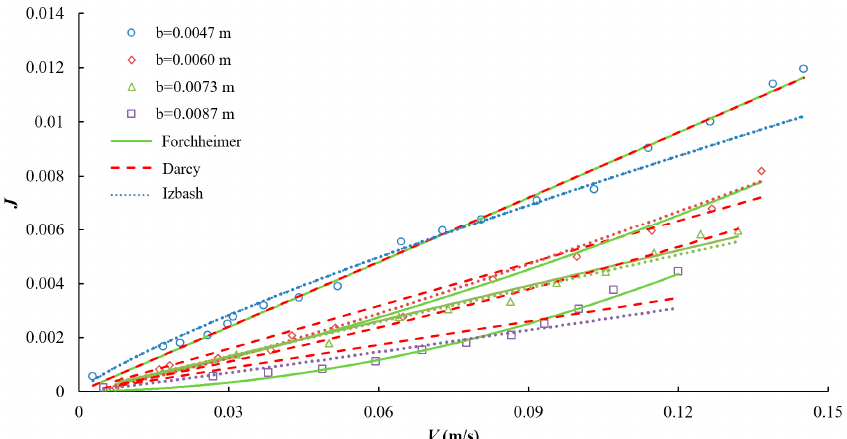
Figure 6. The V – J relationship and fitting results for flow through single fractures with smooth parallel plates.